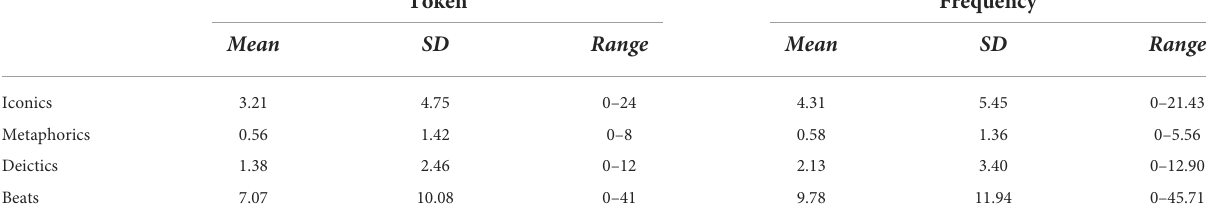
TABLE 3 Descriptive statistics of gesture tokens and